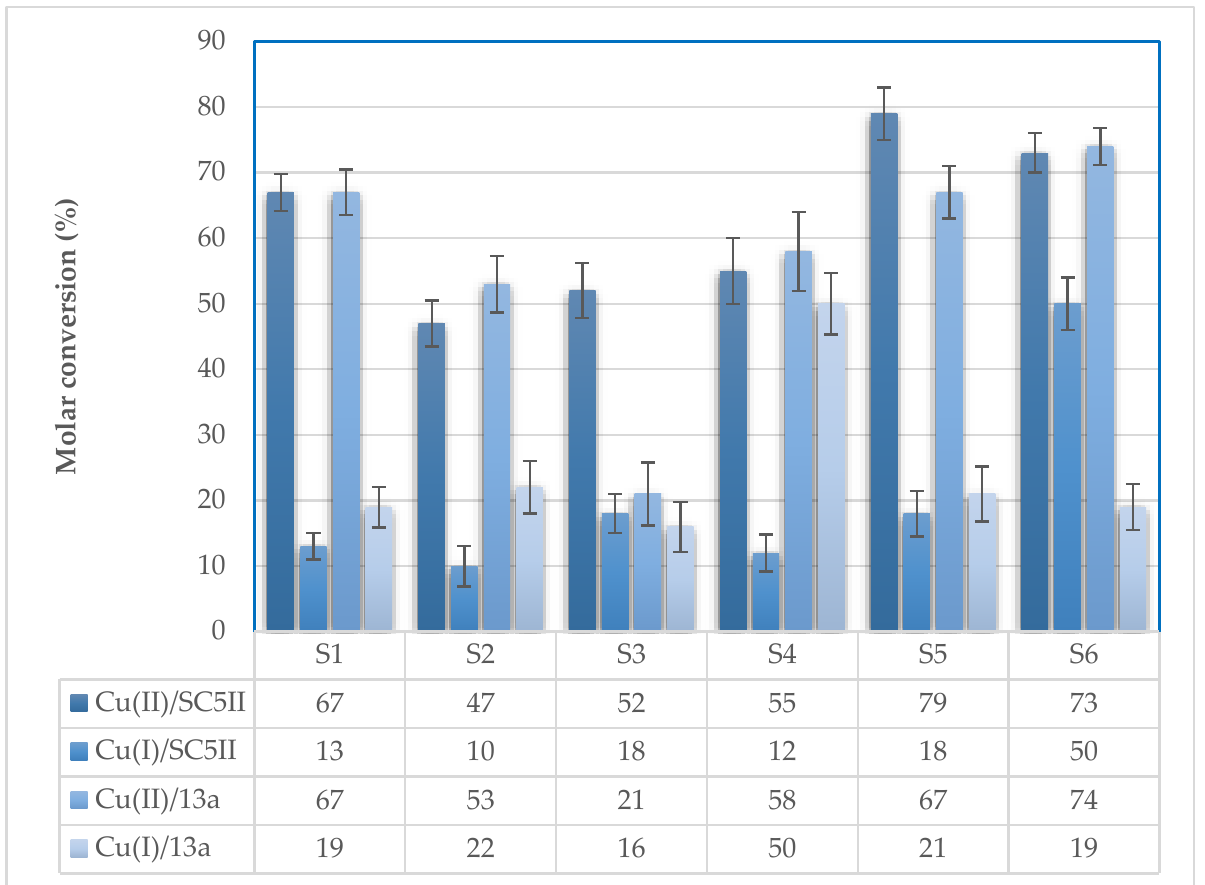
Figure 4. Catalytic evaluation of Cu(I) or Cu(II) hybrid catalysts on different substrates S1 – S6.